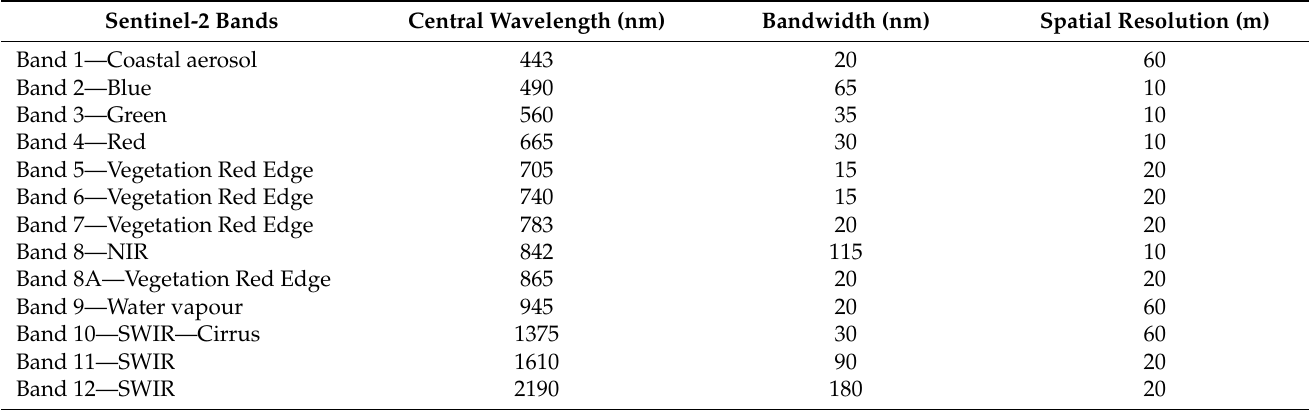
Table 1. S2 band attributes.